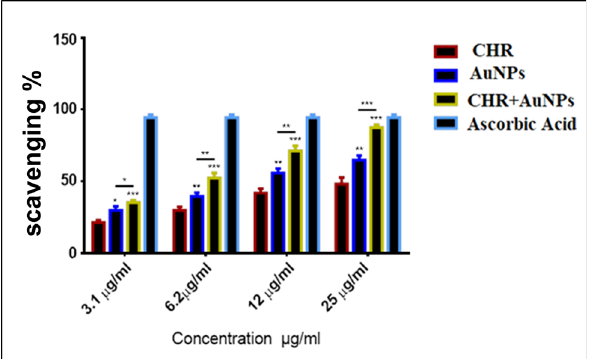
Figure 10: Anti - oxidant activity: CHR – AuNPs, CHR, and AuNPs at di ff erent concentrations; n = 3, * P < 0.05, ** P < 0.01, and *** P <